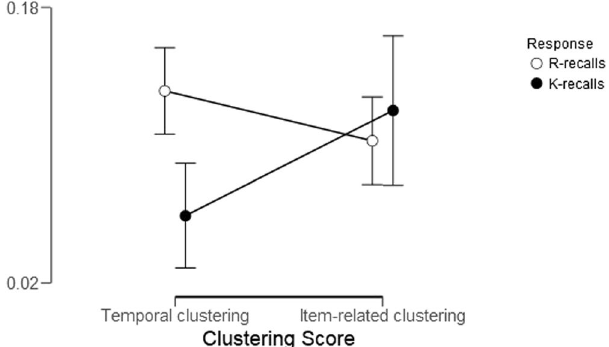
Figure 1. Recall dynamics’ scores for R- and K-recalls. Temporal-clustering scores denote the tendency to successively recall two items which were temporally-adjacent at study. Item-related-clustering scores measure the tendency of successively recalling two items which were given the same judgment at encoding (either ‘abstract’ or ‘concrete’). The measure of clustering scores is the difference between the raw clustering scores and the baseline scores, with a score of 0 representing chance. Thus, all clustering scores are significantly above chance level. Error bars represent 95% confidence intervals around the